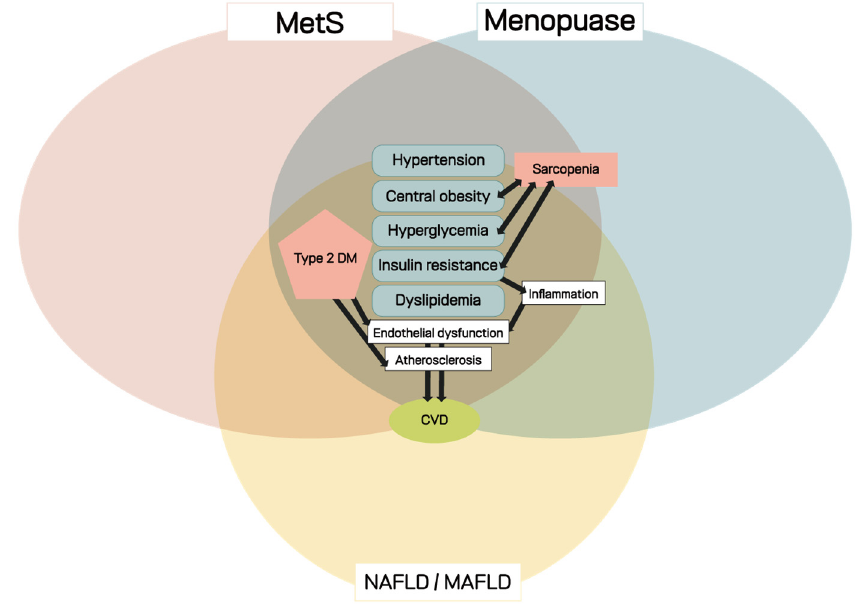
Figure 1. Association of metabolic syndrome, NAFLD/MAFLD, and menopause.